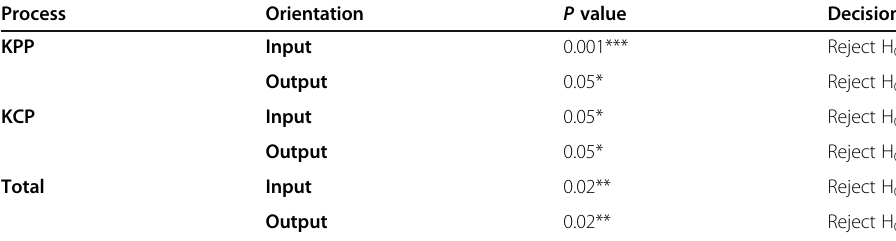
Table 5 RTS-Test of returns to scale Process